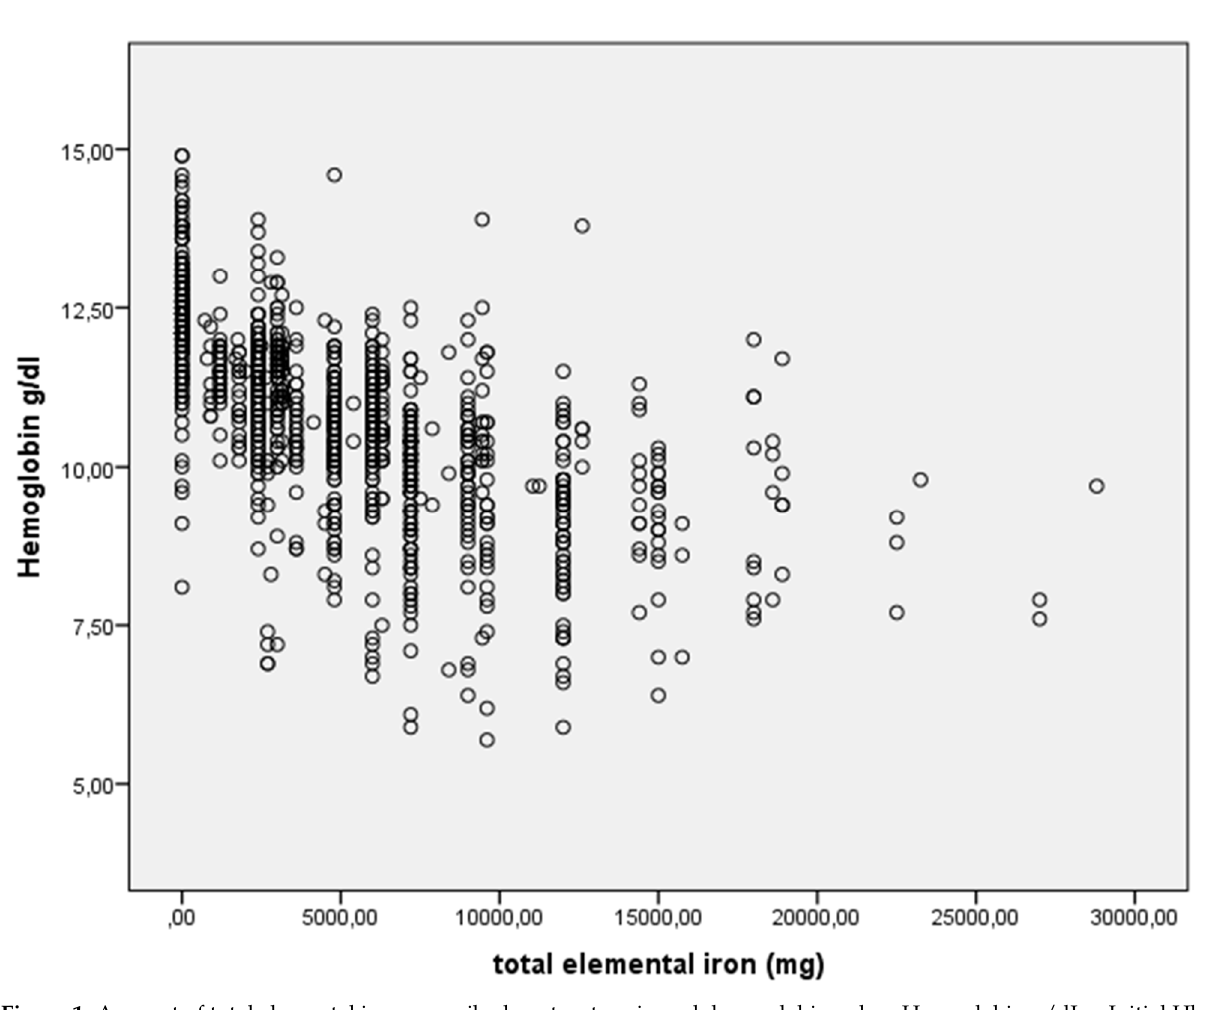
Figure 1. Amount of total elemental iron prescribed postpartum in each hemoglobin value. Hemoglobin g/dL = Initial Hb measured in the first 24 h postpartum. Total elemental iron (mg) = a daily dose of elemental iron in mg. was multiplied by treatment time in days (minimum = 0 mg and maximum = 28.800 mg).